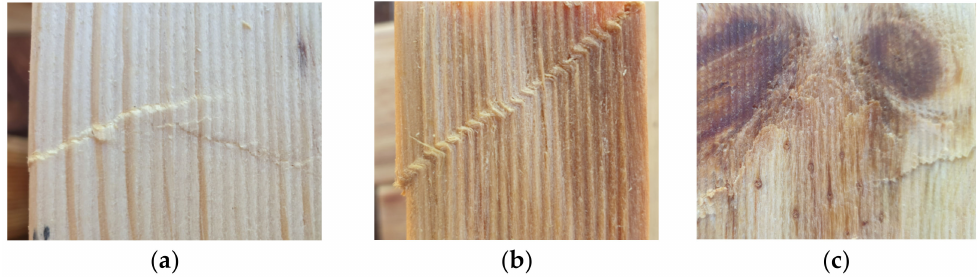
Figure 13. Some typical CParG failure examples in ( a ) clear, ( b ) resin and ( c ) knots.